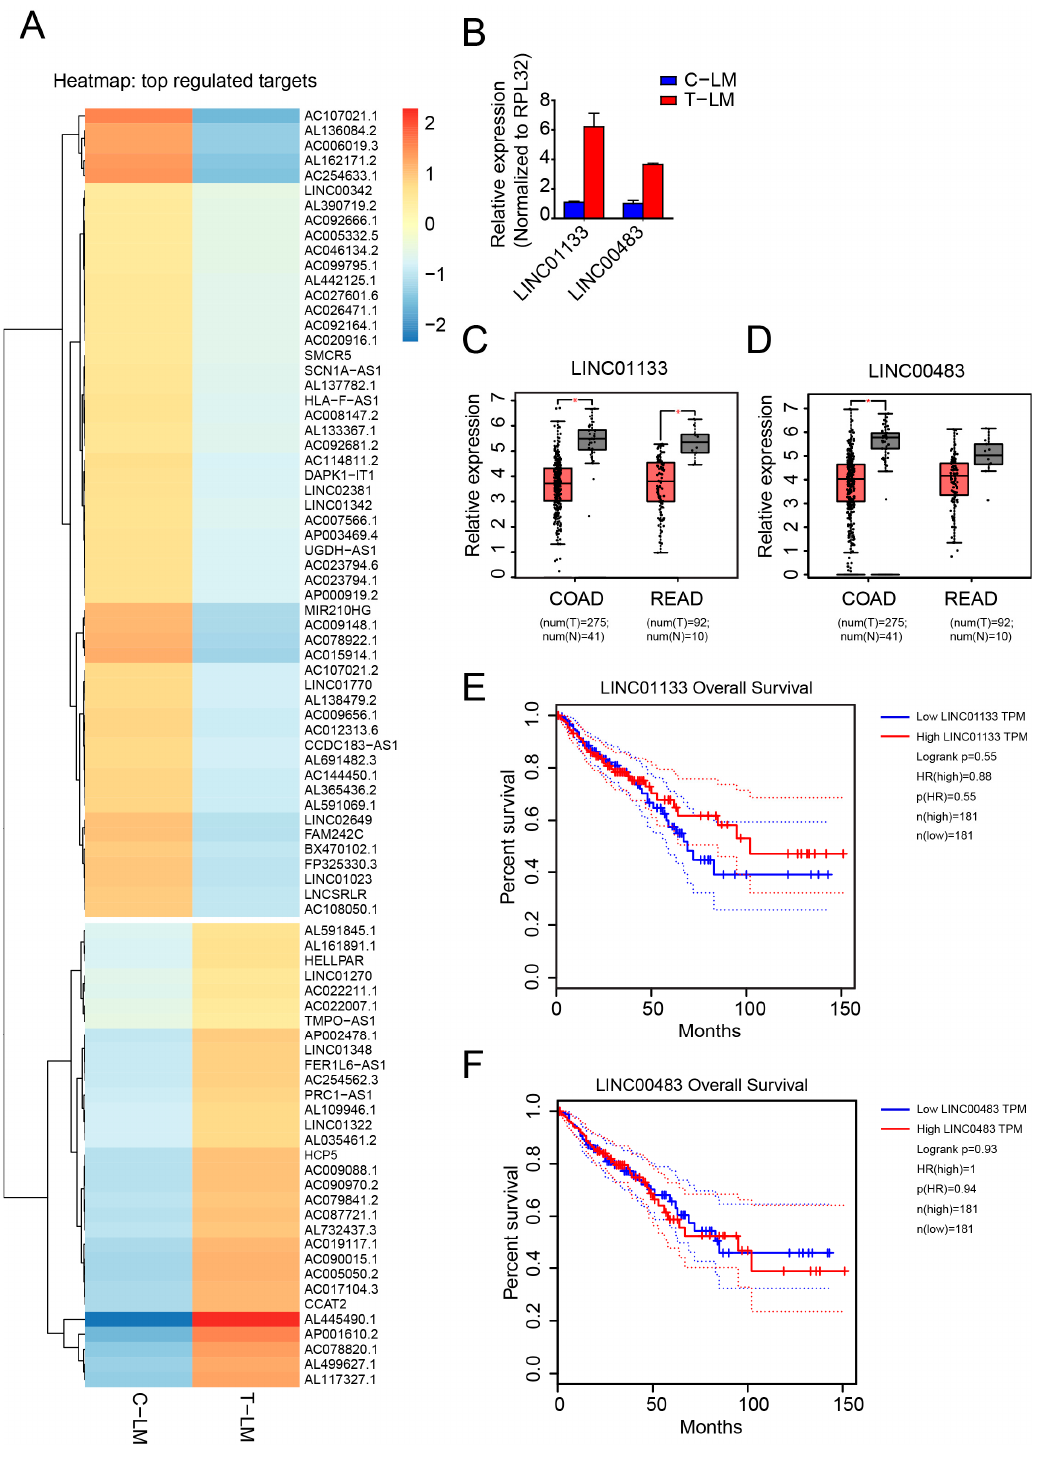
Figure 3. Identification of lncRNAs regulated during LDM topotecan chemotherapy. ( A ) Heatmap of differentially expressed miRNAs in liver metastases from treated mice (T-LM) versus liver metastases from control mice (C-LM). ( B ) Validation of LINC01133 and LINC00483 as downregulated lncRNA from treated liver metastases compared to control liver metastases by qPCR. ( C , D ) Boxplot showing the significant downregulation of LINC01133 and LINC00483 in colon adenocarcinoma (COAD) and rectum adenocarcinoma (READ) obtained from TCGA data, respectively. ( E , F ) Survival plot presents patient survival with expression of LINC01133 and LINC00483 in colon adenocarcinoma (COAD) and rectum adenocarcinoma (READ) obtained from TCGA data, respectively. The data from ( C – F ) was obtained from Gene Expression Profiling Interactive Analysis GEPIA web server